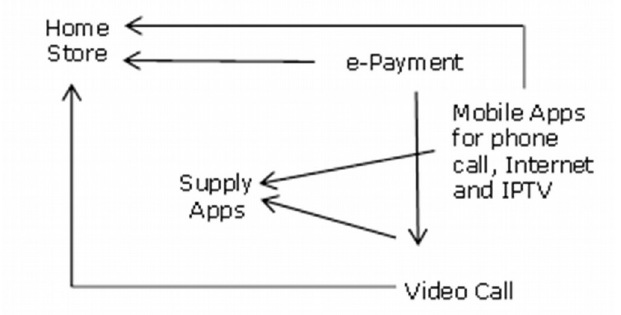
Figure 6. Sample 3 of Home Store Initiative